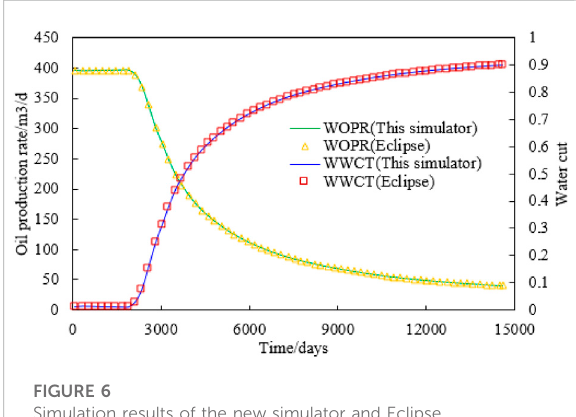
FIGURE 6 Simulation results of the new simulator and